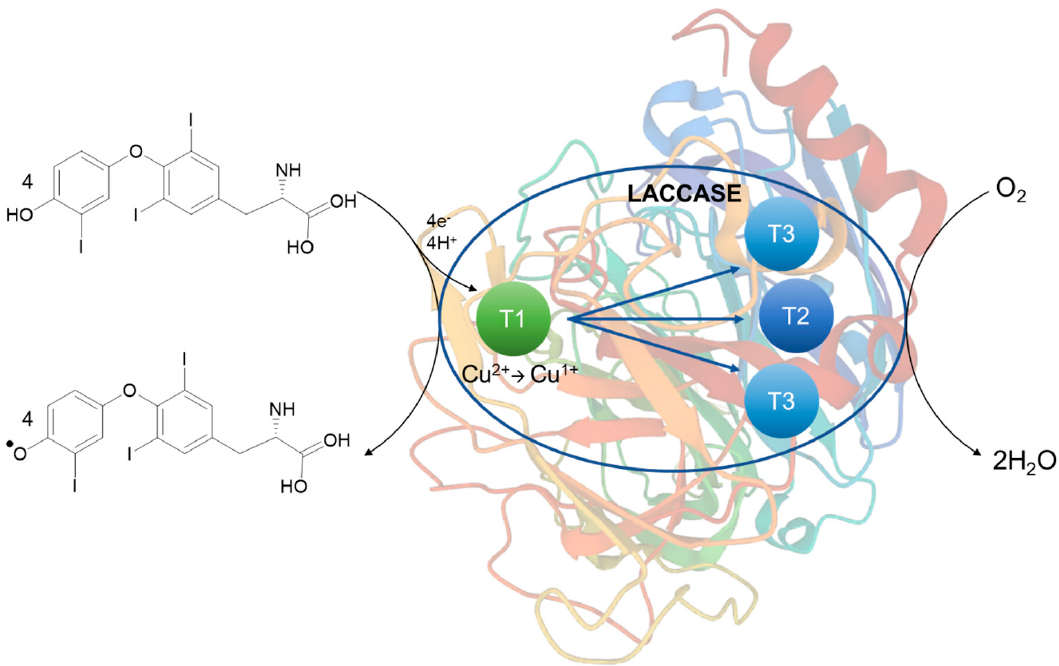
Figure 5. Scheme of the proposed mechanism of the redox enzyme-catalyzed fT3 oxidation.